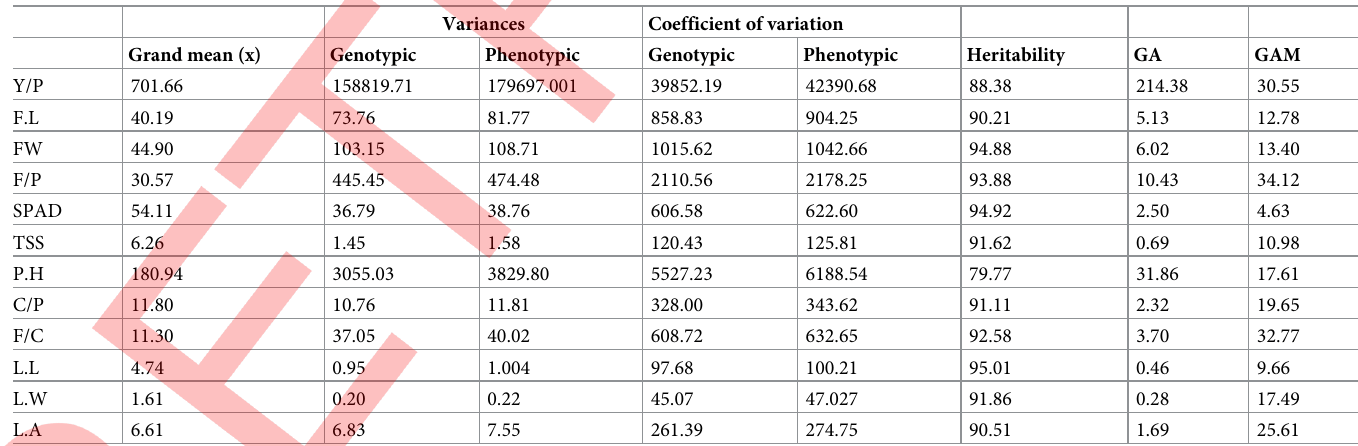
Table 5. Genetic components of agronomic traits of exotic tomato